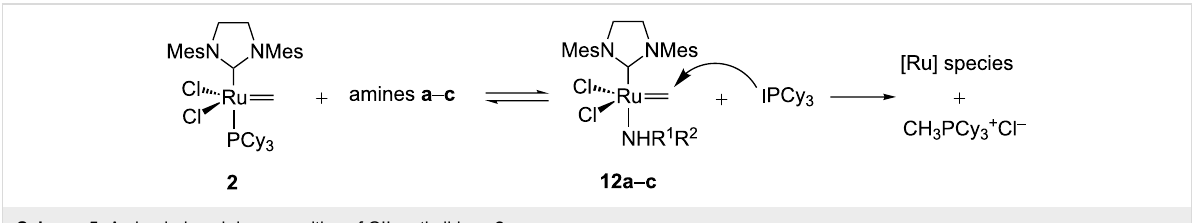
Scheme 5: Amine-induced decomposition of GII methylidene 2